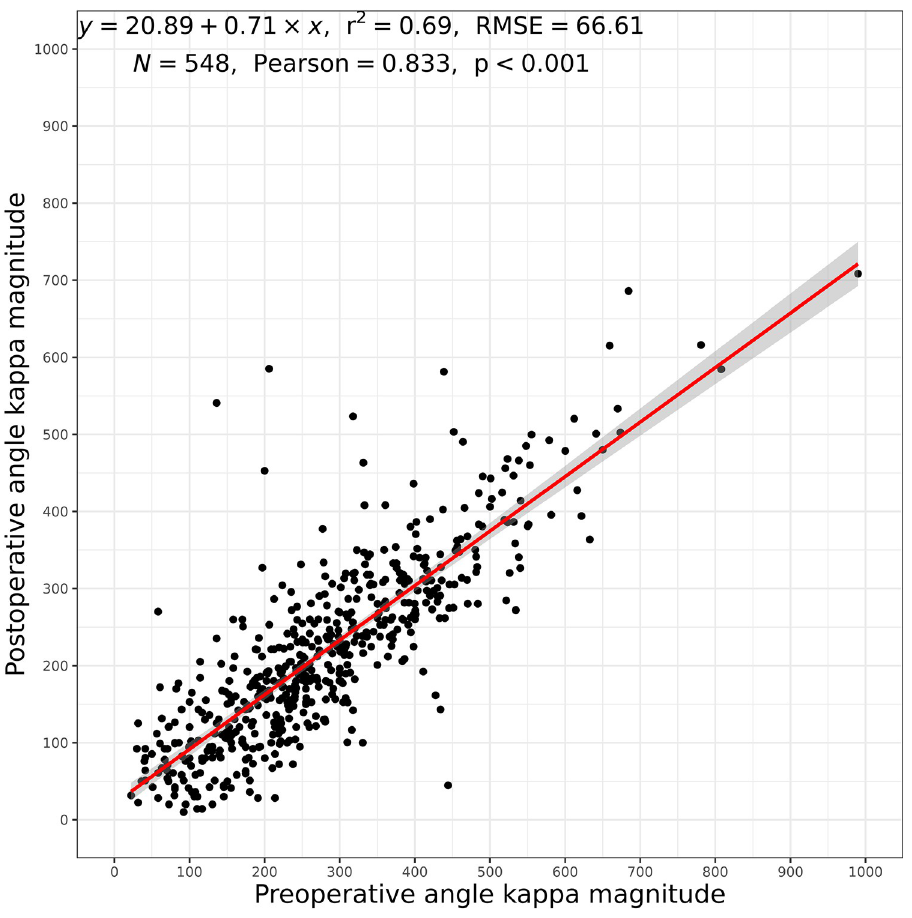
Fig 4. Correlation plot: Change of angle kappa magnitudes (overall group). r 2 : coefficient of determination, RMSE: root mean squared error, N: number of eyes, Pearson: Pearson Correlation Coefficient.